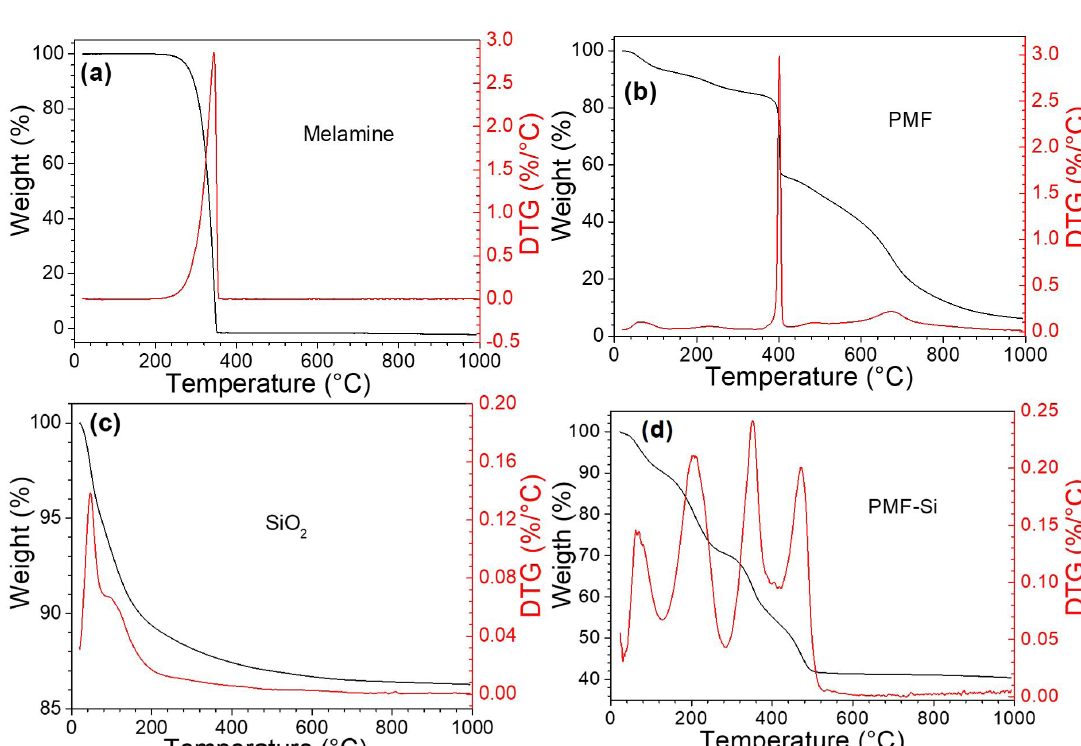
Figure 8. TG and DTG of (a) melamine, (b) PMF, (c) SiO Table 1. Summary of the events related to the thermal properties of melamine, PMF, SiO (%) and the residue from the thermal decomposition of the materials are indicated.